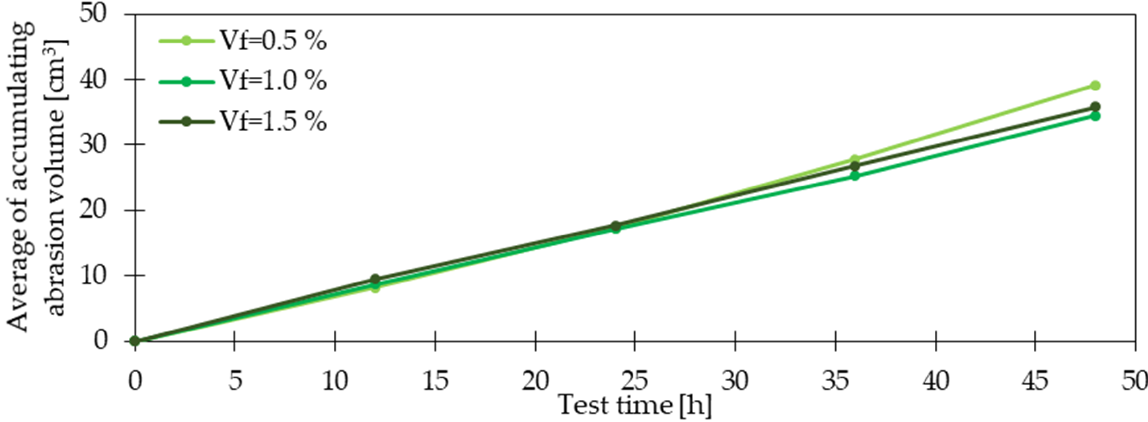
Figure 22. Average of accumulating abrasion volume in relation to the testing time of underwater abrasion resistance test [100].